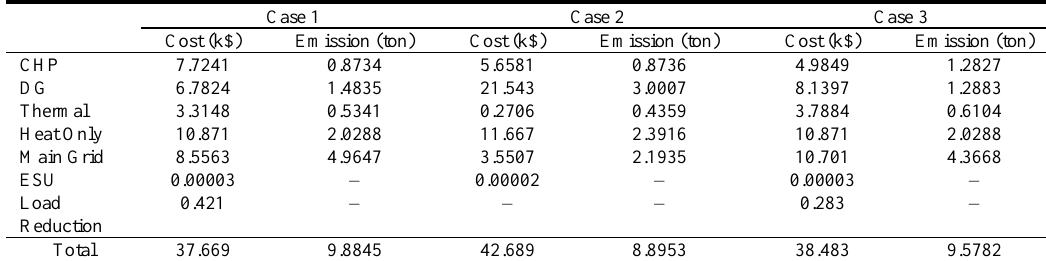
TABLE VII S CHEDULING C OST AND E MISSION C OMPARISON IN T HREE C